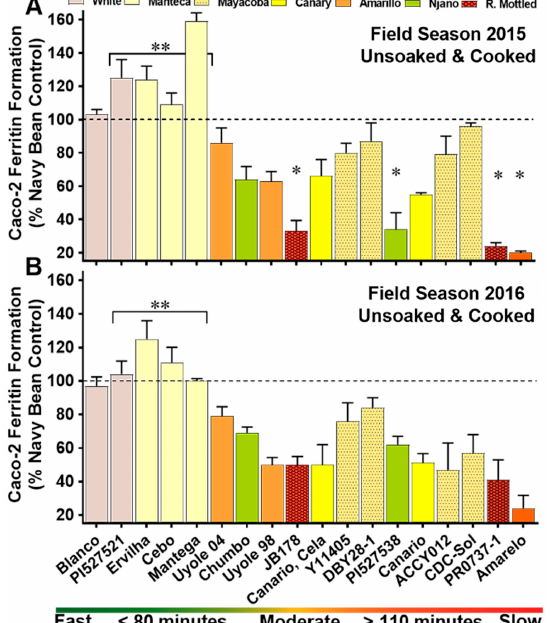
Figure 4. Iron bioavailability scores of unsoaked and cooked whole seed genotypes in the YBP for field season 2015 ( A ) and field season 2016 ( B ). Values are means ( ± Standard Deviation) of triplicate measurements from two field replicates per genotype ( n = 6). Genotypes are categorized on the x-axis by cooking class, ranked from the fastest cooking genotype to slowest cooking entry. * Significantly lower ( p ≤ 0.05) iron bioavailability score when compared to the other YBP entries. ** Significantly higher ( p ≤ 0.05) iron bioavailability scores compared to the other YBP genotypes.